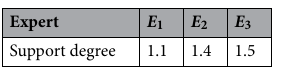
Table 4. The support degree of evidence.